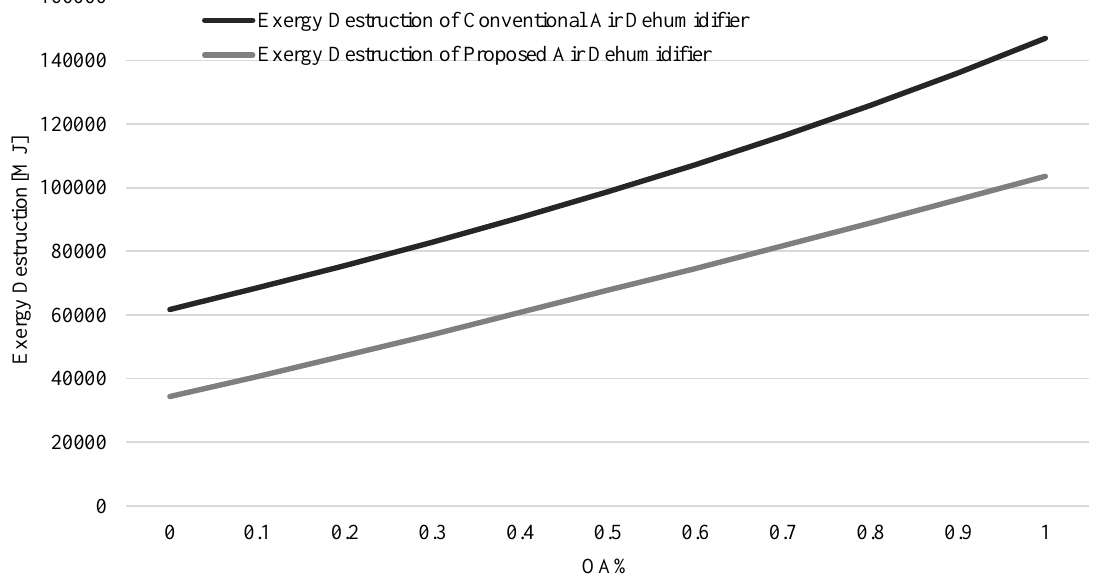
Figure 5. Net exergy destruction variations versus different outside air